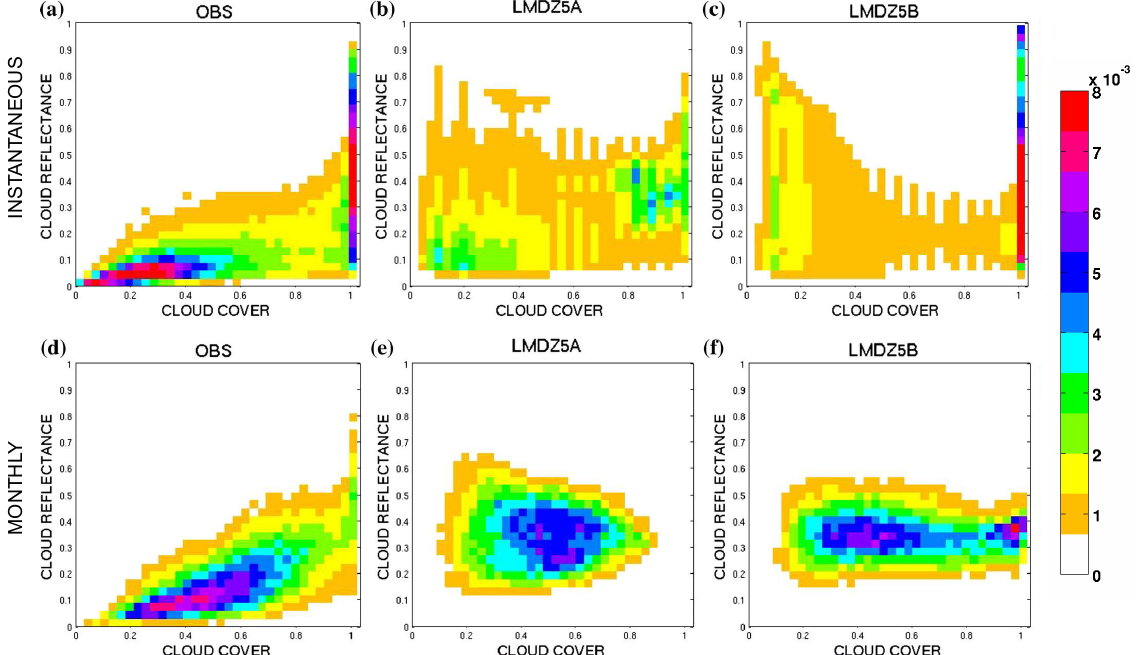
Figure 7. Two-dimensional histograms of cloud reflectance and cloud cover over the tropical oceans using instantaneous data (upper panels) and monthly data (lower panels) (a) , (d) observed with PARASOL and CALIPSO-GOCCP, (b) , (e) simulated with LMDZ5A and the simulator, and (c) , (f) simulated with LMDZ5B and the simulator. The colour bar represents the number of points at each grid cell (cloud cover–cloud reflectance) divided by the total number of points. Reprinted with permission from Konsta et al.